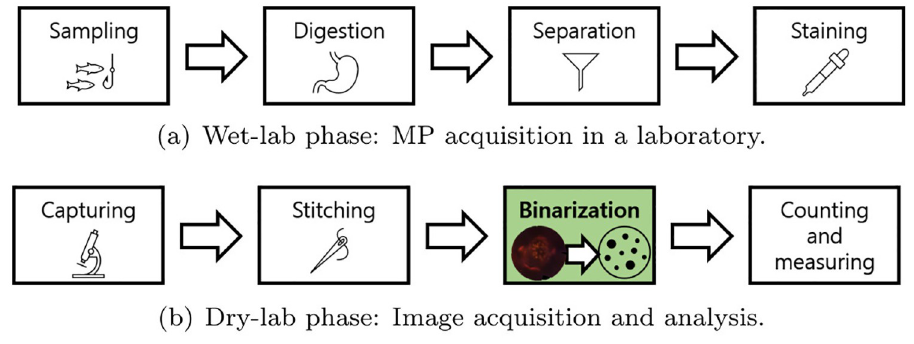
Fig 1. Overview of MP measurement. Overall approach towards MP measurement, from sampling to image processing: (a), (b) corresponds to the complete MP measurement process we made use of. We propose a new binarization method (green-colored box) that uses deep learning. (a) Wet-lab phase: MP acquisition in a laboratory. (b) Dry-lab phase: Image acquisition and analysis.